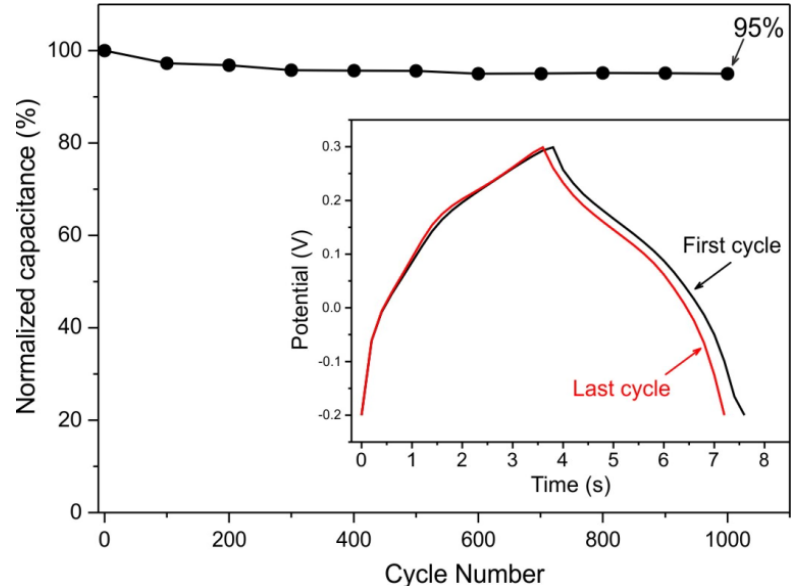
Figure 8. Cycling stability of the Re-Co 3 O 4 electrode tested at a current density of 12 A g −1 . The inset shows the GCD curves at a current of 12 A g −1 during the first and last cycles.